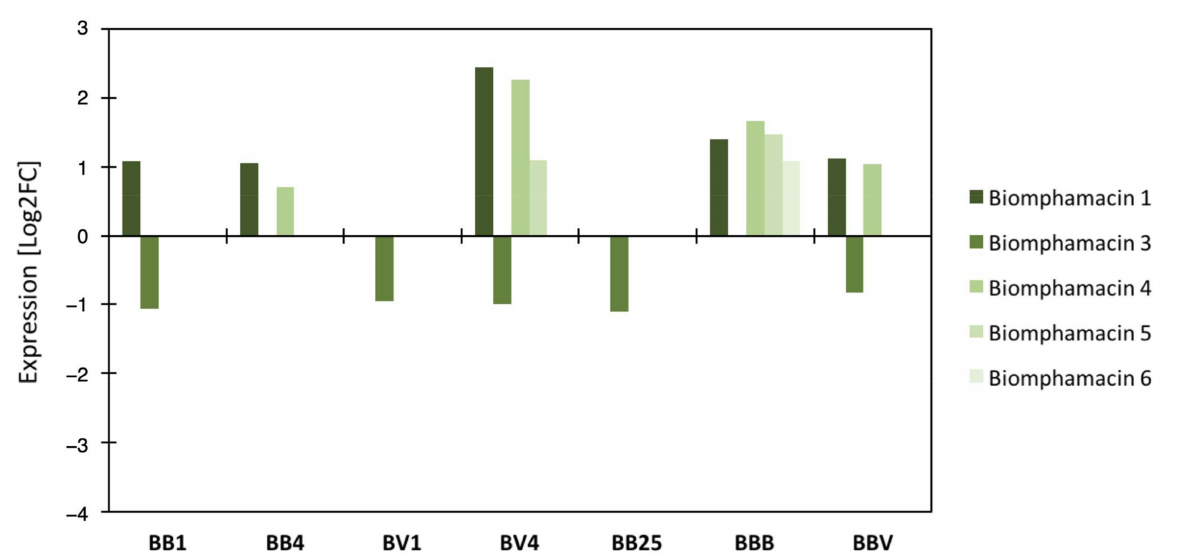
Figure 6. Differential gene expression of Biomphamacin antimicrobial peptides: Log2FC (fold change) of antimicrobial immune transcripts between naive and infected snails inferred from previous RNAseq analysis on the same experiment. A positive Log2 fold-change indicates over-expression in infected snails compared to the naive snails. Antimicrobial peptide families included 6 Biomphamacins (macin-like AMPs) consisting of 6 genes (shade of